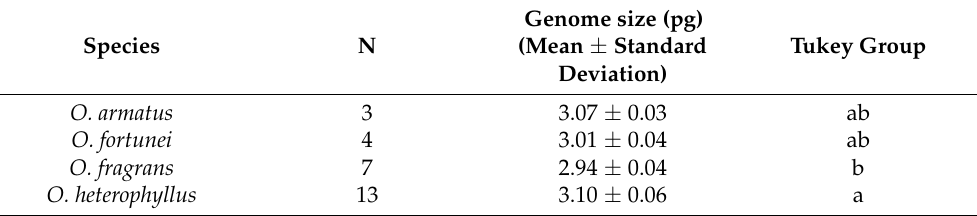
Table 3. Genome size of four Osmanthus species. Means followed by the same letter were not significantly different at the α = 0.05 significance